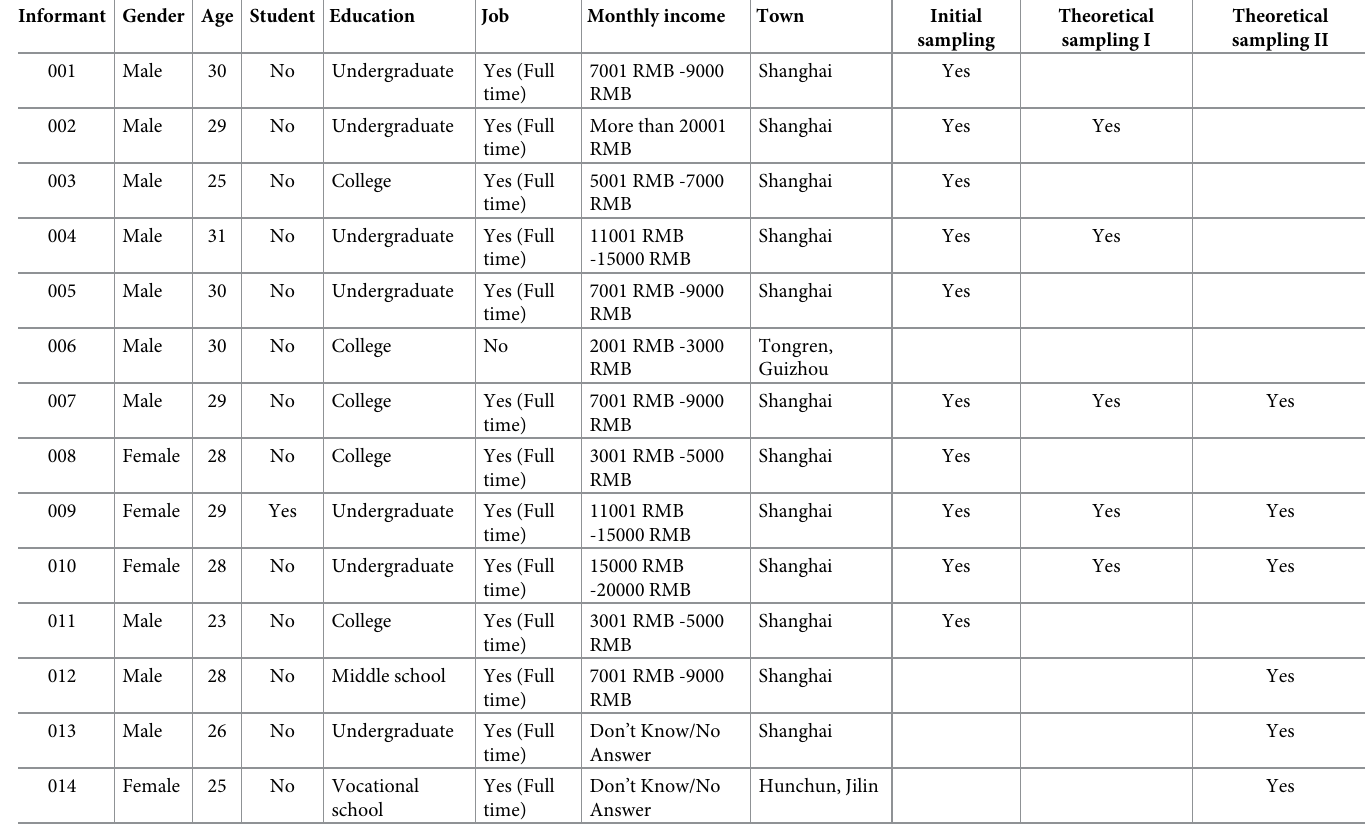
Table 2. Gaming profile of the